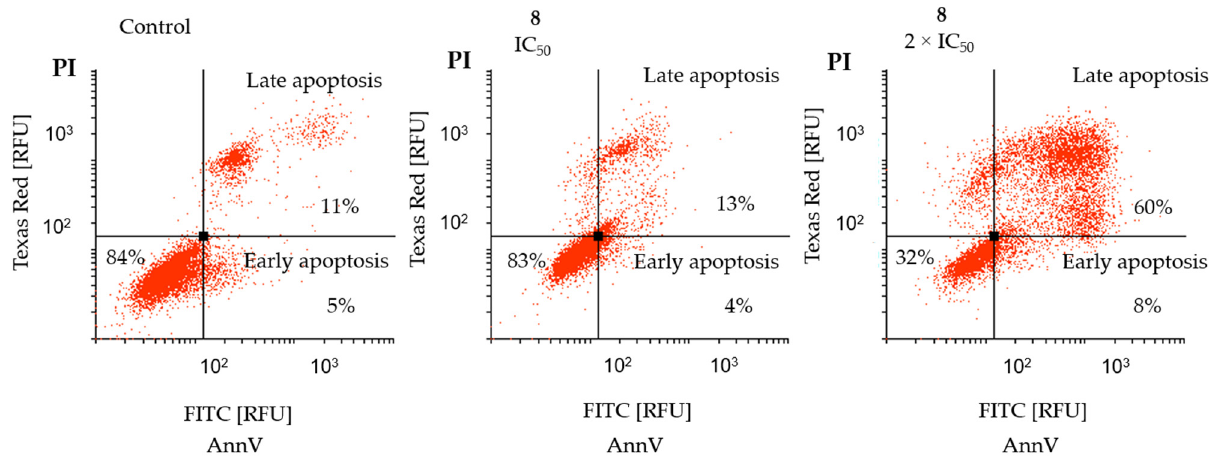
Figure 4. The impact of compound 8 on the apoptosis induction in PC3 cells. 8 was tested using IC 50 , 2 × IC 50 concentrations for 48 h (AnnV/PI assay).